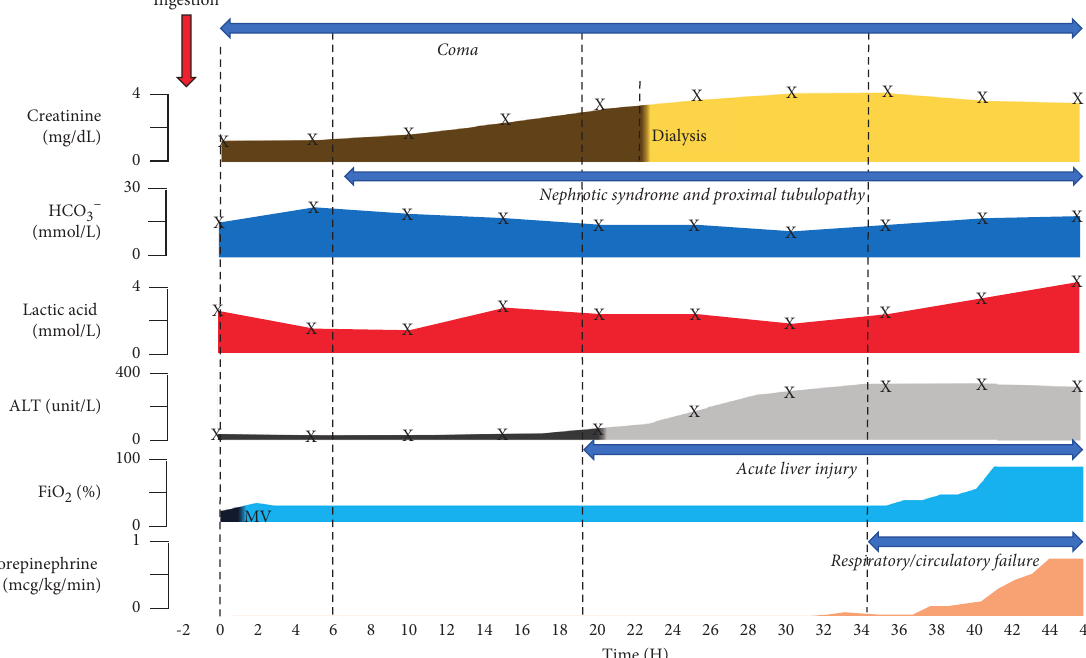
Figure 1: Schematic presentation of the clinical course presented by the patient from admission to the fatal outcome. Trends of the most relevant blood tests, the inspired fraction of O 2 required to maintained SaO 2 > 90%, and the level of vasopressor (norepinephrine) support after diquat ingestion are displayed. ALT, alanine aminotransferase; HCO − , bicarbonate; MV, mechanical 3